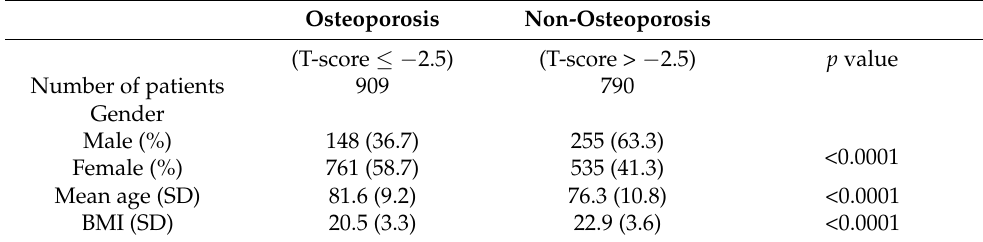
Table 1. The clinical and demographic characteristics of the